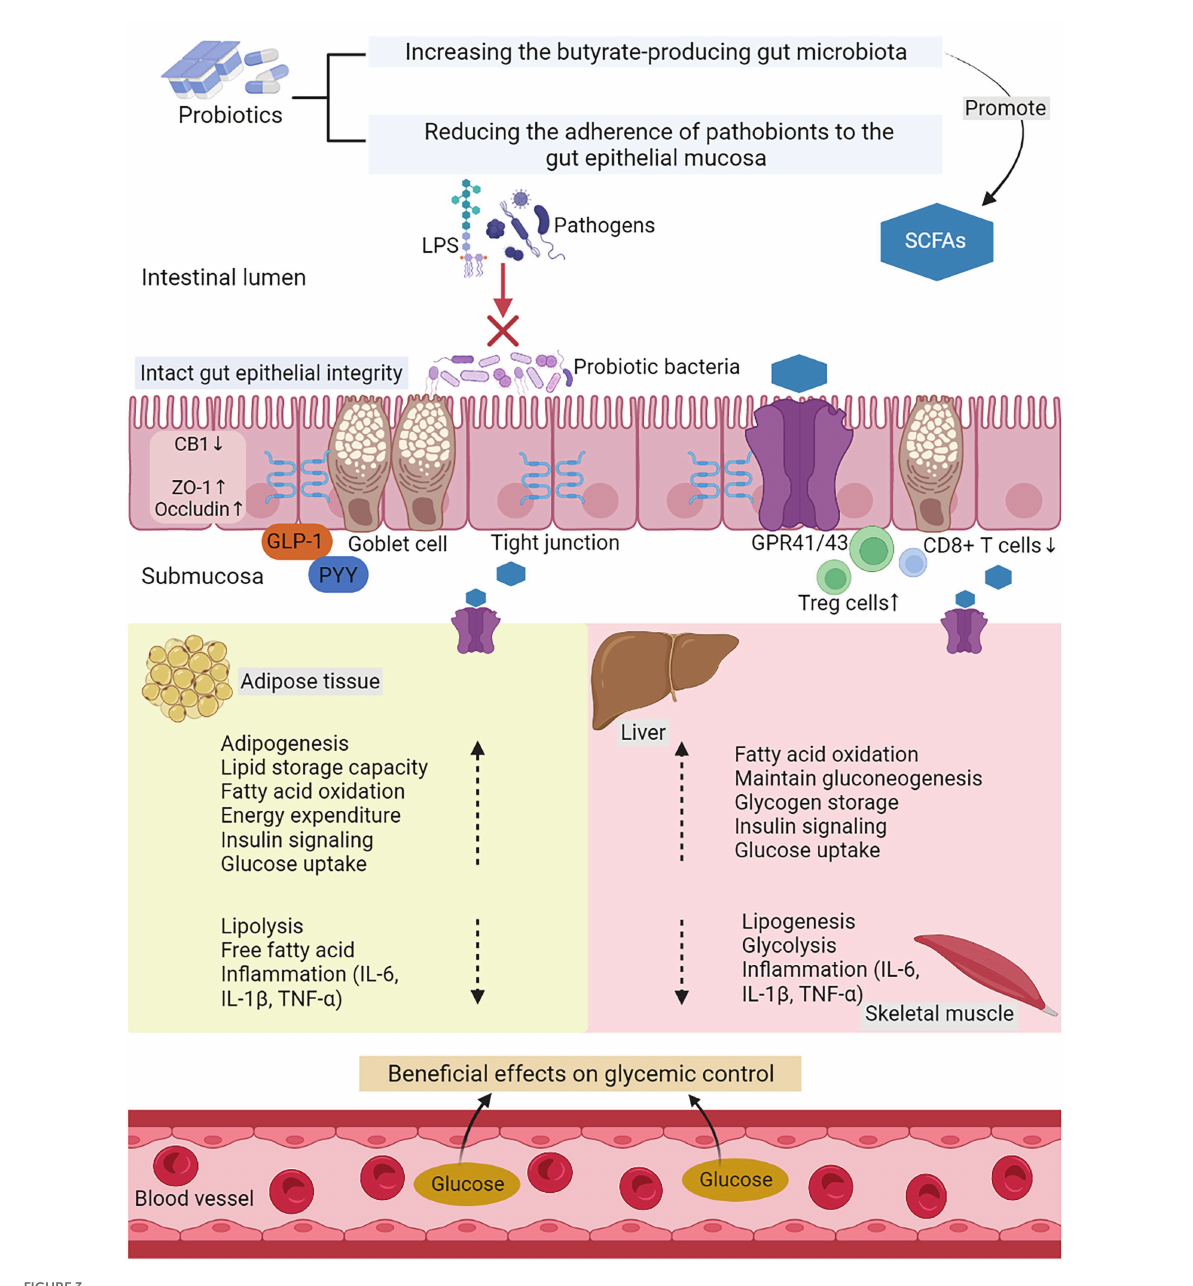
FIGURE 3 The possible mechanisms of action of probiotics in GDM. LPS, lipopolysaccharide; SCFAs, short-chain fatty acids; GPR 41/43, G-protein-linked receptor 41/43; CB1, cannabinoid receptor 1; ZO-1, zona occludens 1; GLP-1, glucagon like peptide-1; PYY, peptide YY; Treg cells, regulatory T cells; IL-6, interleukin-6; IL-1 β , interleukin-1 β ; and TNF- α , tumor necrosis factor- α